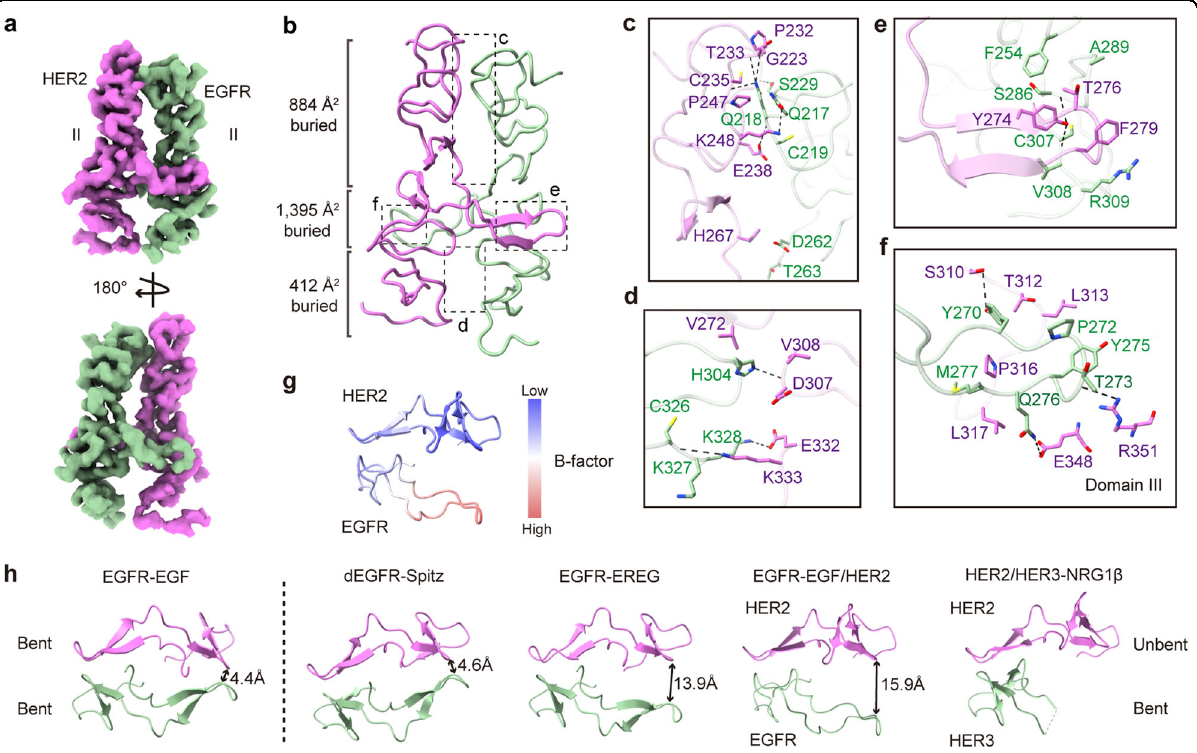
Fig. 3 Interaction details between EGFR and HER2. a Cryo-EM map of the interface between Domain IIs of EGFR and HER2 shown in two views. b Structure of the EGFR/HER2 interface in ribbon presentation. EGFR is colored in green and HER2 is in magenta. The BSAs of different regions are indicated. c – f Interaction details between EGFR and HER2 as indicated in the insets of b . Residues involved in their interaction are shown with side chains. Black dashed lines represent hydrogen bond or salt bridge interactions (< 4.5Å). g B-factor distribution of the DAs in the EGFR – EGF/HER2 structure. h Comparison of the structures of DAs in different HER dimers. From left to right: EGFR – EGF (PDB code: 1IVO), dEGFR – Spitz (PDB code: 3LTG), EGFR – EREG (PDB code: 5WB7), EGFR – EGF/HER2 (this study), and HER2/HER3 – NRG-1 β (PDB code: 7MN5). The DAs of the symmetric EGFR dimer exhibit the same conformation. For asymmetric dimers, the DAs of the unbent subunit pack closely with its counterpart, mimicking that of the symmetric EGFR dimer, whereas those of the bent subunit display various structures. The distances between DAs of the bent subunits and their partners are